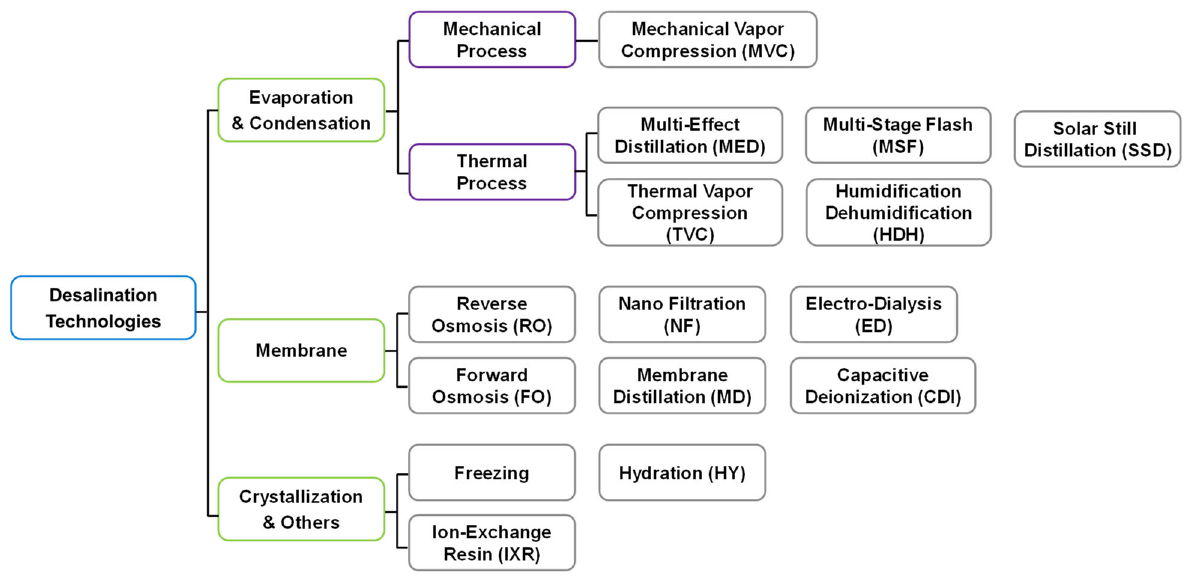
Figure 1. Categories of desalination technologies.